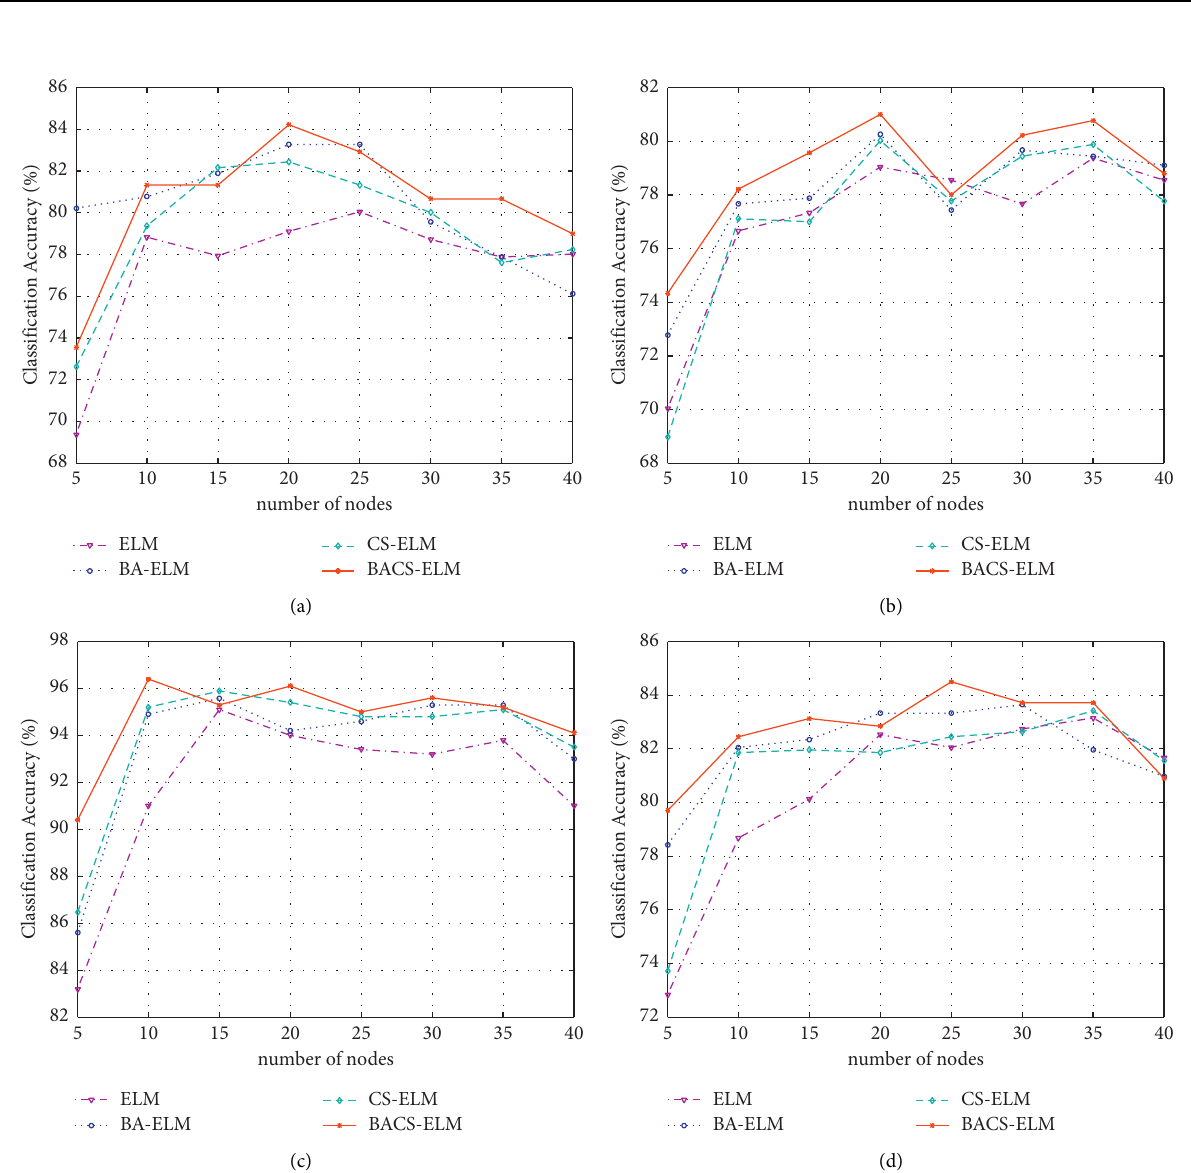
Figure 3: The graph of the classification accuracy over different datasets with the change of the number of nodes: (a) breast cancer; (b) heart failure; (c) iris; (d) vertebral